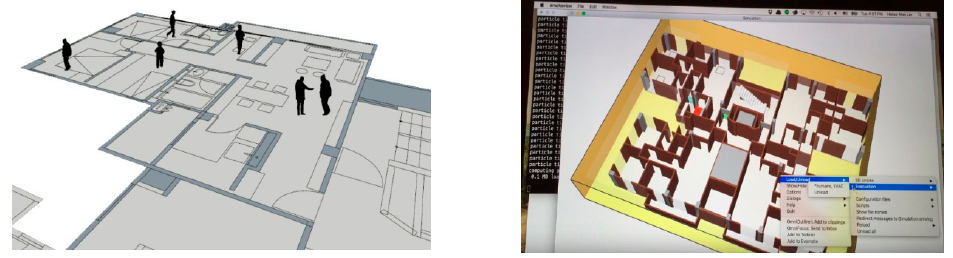
Figure 6. Evacuation time simulation of design targeting 100 years.